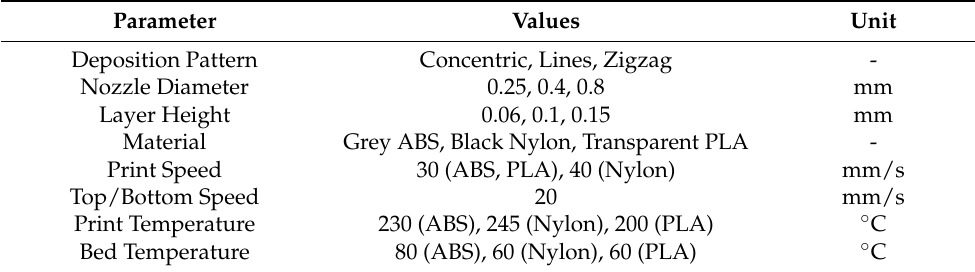
Table 2. FFF printing parameters considered in the